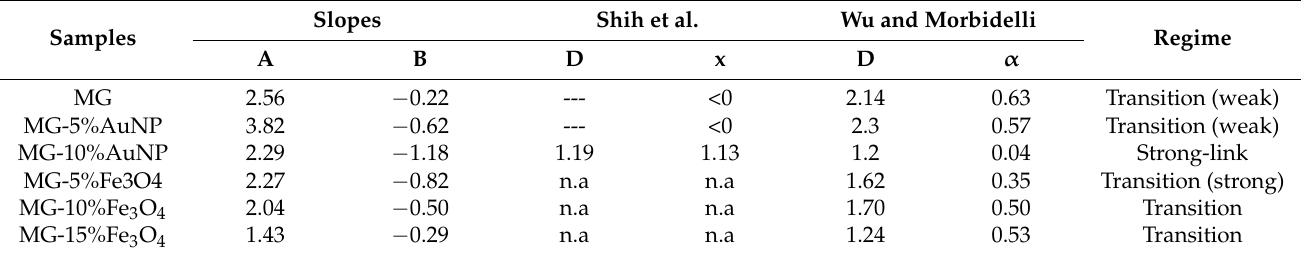
Table 1. Summary of the results obtained by applying Shih et al. and Wu and Morbidelli models